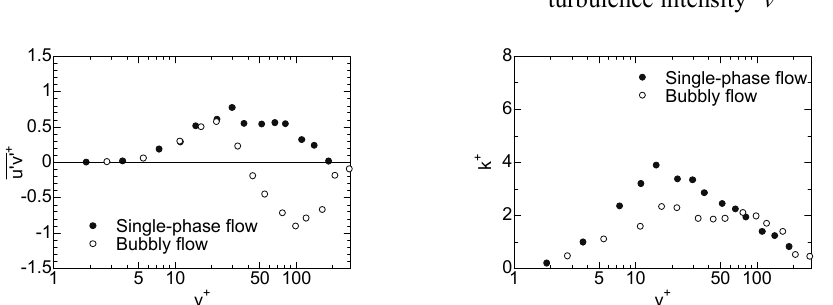
Fig. 16 Wall-normal component of turbulence intensity